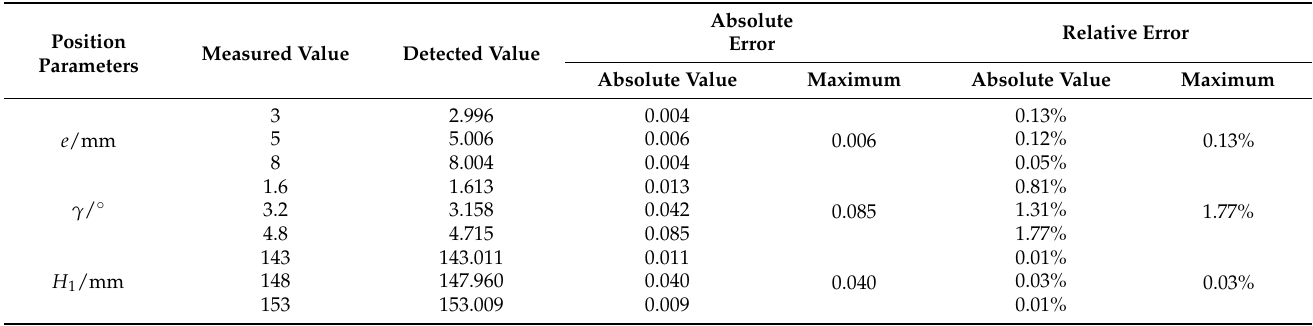
Table 4. Position parameters detection of camera (characterizing welding torch) relative to weld- ing groove.